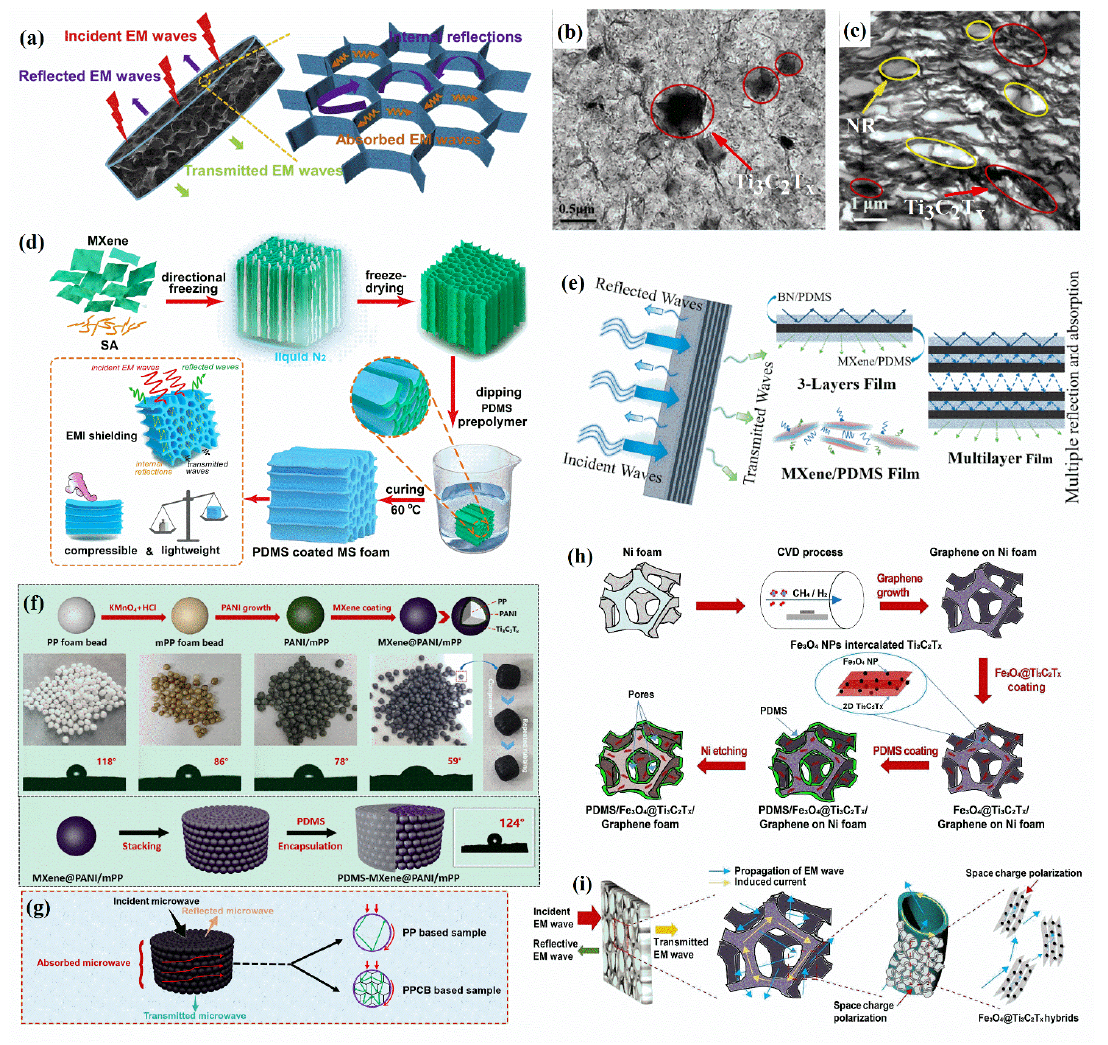
Figure 6. ( a ) EMI shielding mechanisms of MXene/NR nanocomposite films (Reprinted with permission from Ref. [20]. Copyright 2019, copyright Elsevier). Transmission electron microscopy images of ( b ) brick–mortar and ( c ) honeycomb structures (Reprinted with permission from Ref. [62]. Copyright 2021, copyright Elsevier). ( d ) Schematic of fabrication of MXene/sodium alginate hybrid aerogel and PDMS-coated foam (Reprinted with permission from Ref. [16]. Copyright 2019, copy- right Elsevier). ( e ) Schematic of EMI shielding mechanism of MXene/BN/PDMS multilayer films (Reprinted with permission from Ref. [55]. Copyright 2020, copyright Elsevier). ( f ) Schematic of fab- rication of PDMS/MXene@PANI/PP composite foams (Reprinted with permission from Ref. [63]. Copyright 2020, copyright Elsevier). ( g ) EMI shielding mechanisms of composite foams (Reprinted with permission from Ref. [63]. Copyright 2020, copyright Elsevier). ( h ) Schematic of fabrication of Fe 3 O 4 @Ti 3 C 2 T x /graphene/PDMS (Reprinted with permission from Ref. [64]. Copyright 2020, copy- right Elsevier). ( i ) Schematic of electromagnetic wave absorption in Fe 3 O 4 @Ti 3 C 2 T x /graphene/PDMS composite (Reprinted with permission from Ref. [64]. Copyright 2020, copyright Elsevier). (SA: so- dium alginate; EM: electromagnetic; MS: MXene/sodium alginate; PPCB: polypropylene/carbon black). The results of electrostatic repulsion and other interactions between natural latex and MXene ensure the even dispersion of MXene in the matrix and form an ordered network,